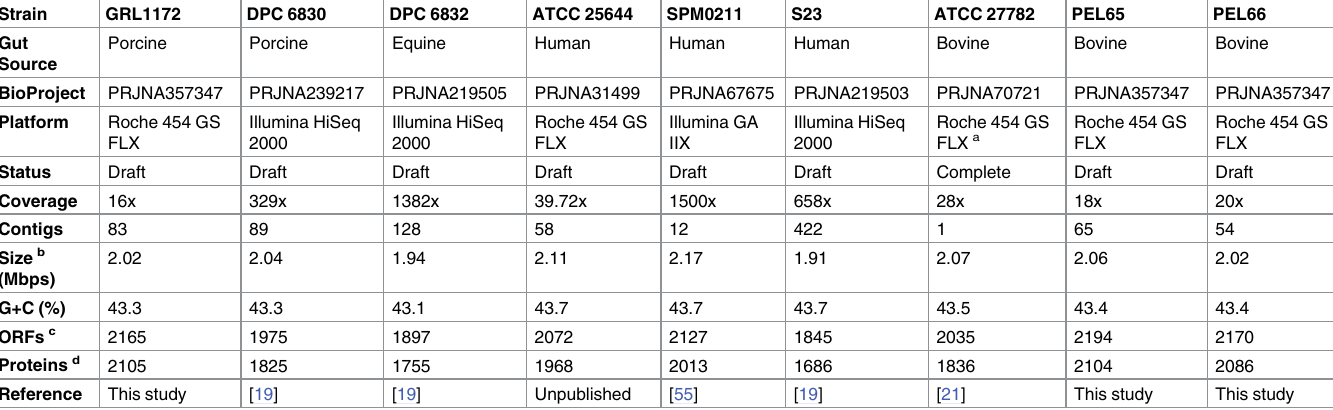
Table 1. Overview of the L . ruminis genome sequences in this